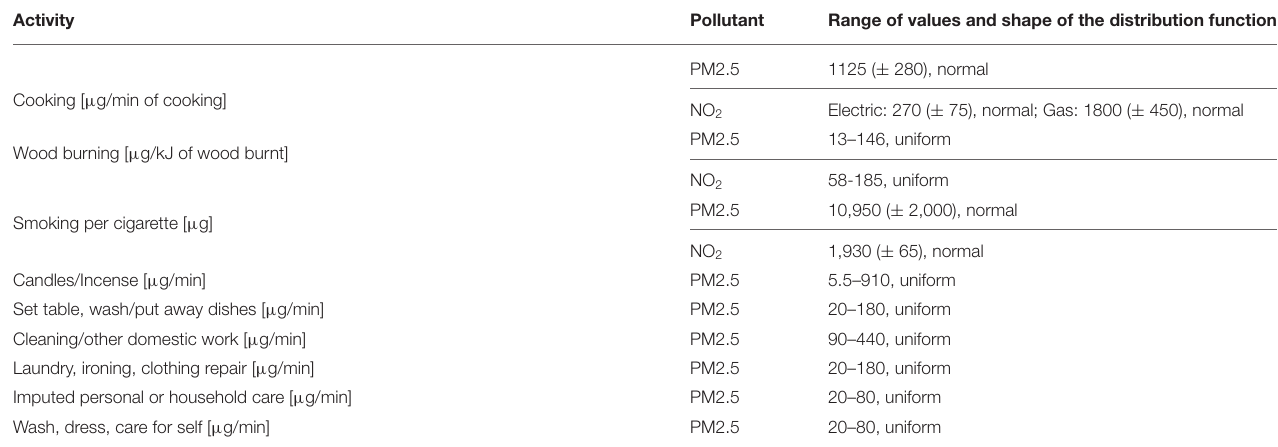
TABLE 2 | Values of source